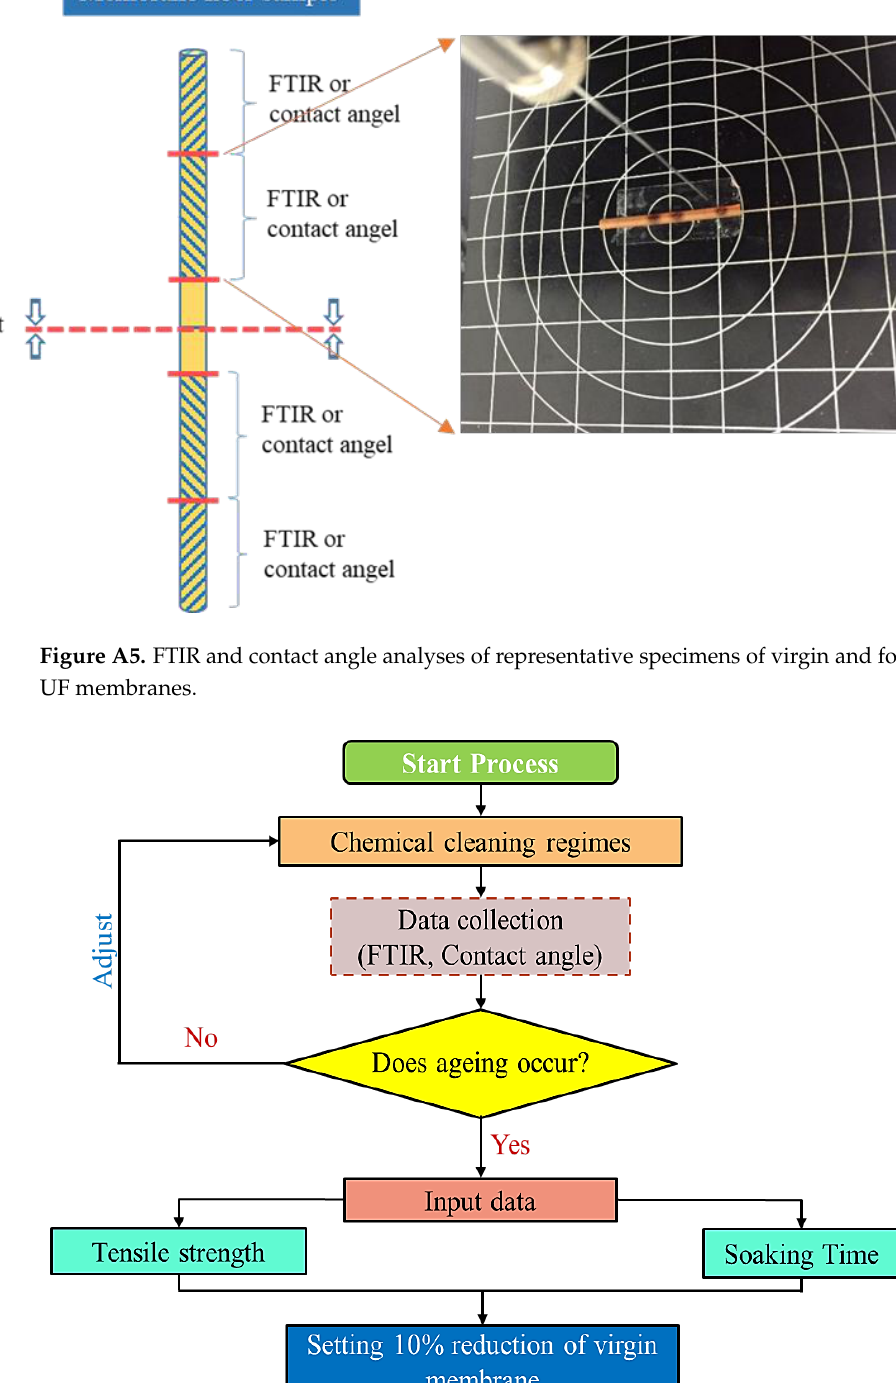
Figure A4. Transmembrane pressure graph.